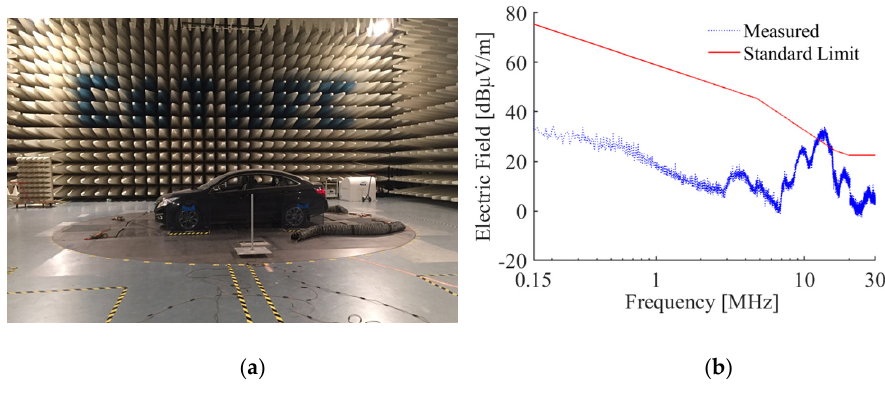
Figure 5. Radiated emission test: ( a ) Test site; ( b ) Electric field.